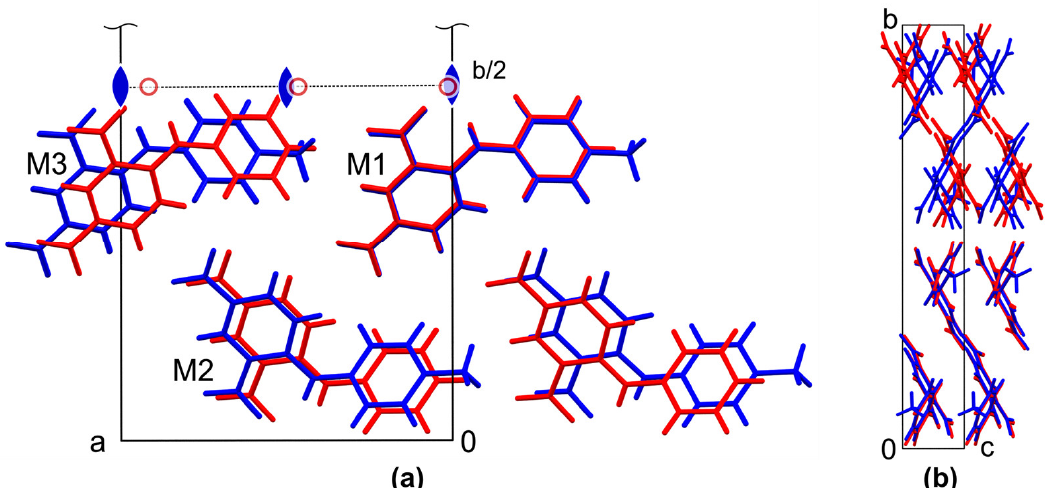
Figure 3. Fragments of crystal packing of eight molecules in polymorph I of 1 (blue) and 2 (red), demonstrating partial quasi-isostructurality of the solids. The unit cell is taken from polymorph I , view along the crystallographic c axis ( a ) and crystallographic a axis ( b ). Symmetry elements that generate the second half of the unit cell on ( a ) are depicted by symbols of the corresponding color.